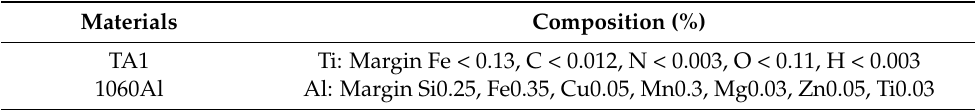
Table 1. Chemical compositions of TA1 titanium and 1060 aluminum alloy